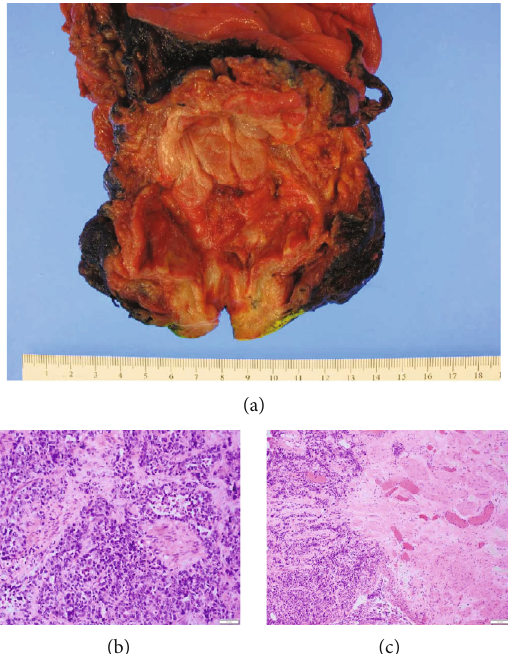
Figure 4: (a) For case 2, sectioning of excised bladder revealed a 8.5cm irregular solid mass grossly invading into the hilar fat and into perinephric fat. (b, c) Hematoxylin and eosin stain showed muscle-invasive urothelial carcinoma on histology of tissue from initial diagnostic transurethral resection of bladder tumor ( × 200 and × 40 magni fi cation,